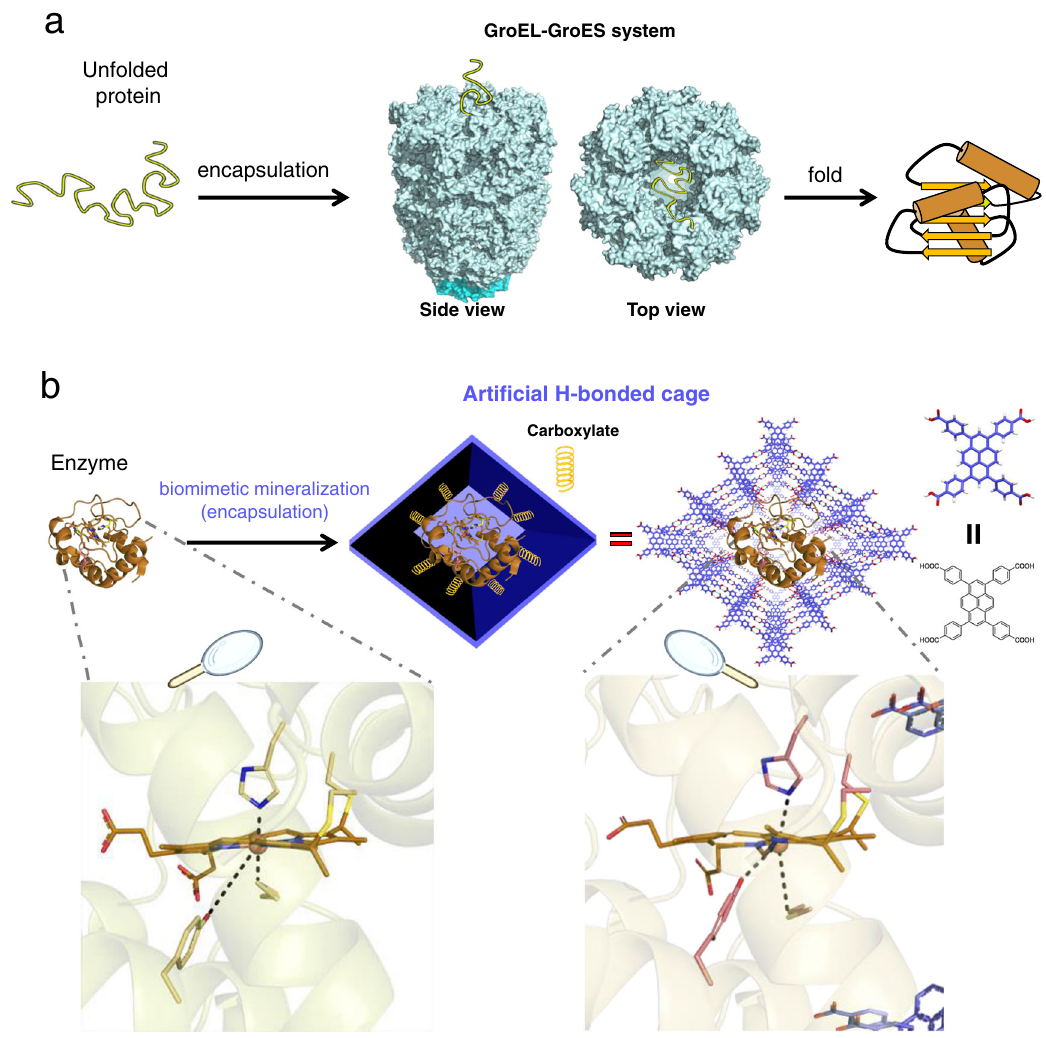
Fig. 1 | Modulating the conformation of an enzyme by H-bonded cage encap- sulation. a Schematicillustration of the protein folding in the typicalGroEL-GroES chaperoninsystem(PDB:1pf9) 16 . b SchematicillustrationofthedesignedH-bonded nanocage for modulating the conformation of an enzyme, Cyt c (PDB: 6k9i). The